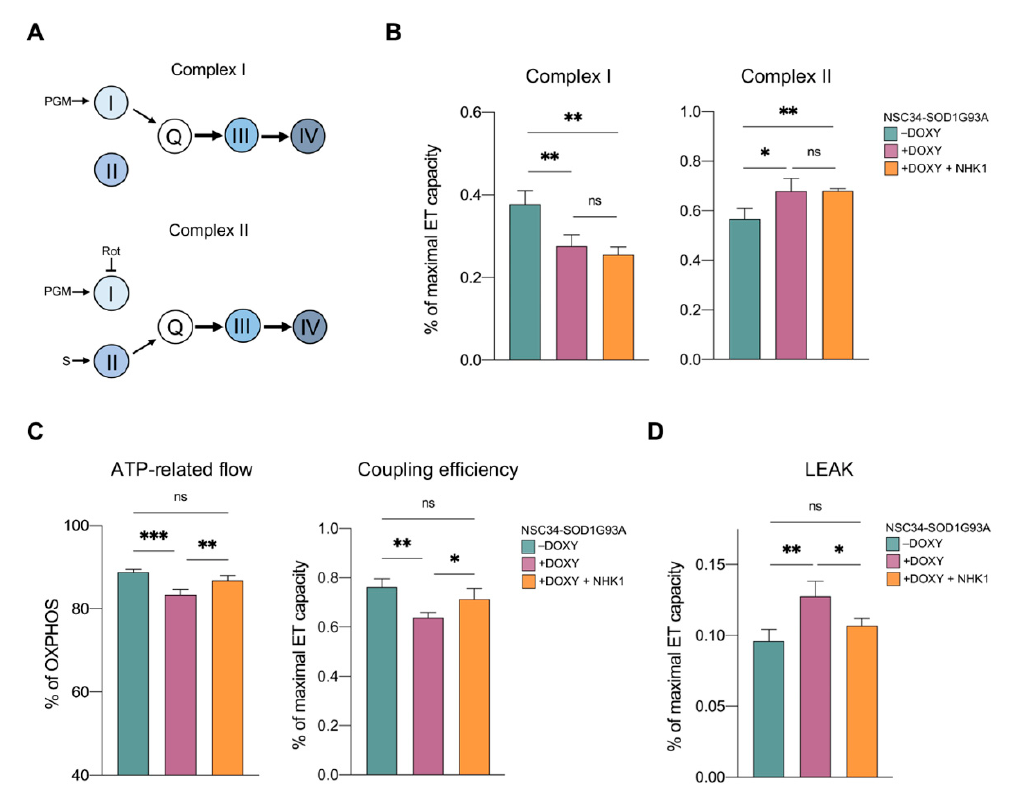
Figure 3. NHK1 peptide improves mitochondrial ATP production but not complex I activity. Oxygen consumption and coupling efficiency of +/ − DOXY NSC34-SOD1G93A cells, previously treated with NHK1 peptide or DMSO. ( A ) Schematic representation of the experimental set-up for the analysis of OXPHOS respiration sustained by complex I (upper) or maximal ET capacity sustained by complex II (lower). Pyruvate (P), malate (M), and glutamate (G) are the reducing substrates that stimulate complex I. Succinate (S) stimulates specifically complex II while rotenone (Rot) specifically inhibits complex I. ( B ) Quantitative analysis of complex I and II activity measured as explained in A. ( C ) Quantitative analysis of the OXPHOS flux related to the ADP phosphorylation and the coupling efficiency in the OXPHOS state. ( D ) Quantitative analysis of the LEAK state. Data are showed as FCRs of the maximal ETS capacity or as percentage of the relative state. Data are expressed as means ± SD of n = 4 independent experiments and analyzed with one-way ANOVA. * p < 0.05, ** p < 0.01 and *** p < 0.001; ns, not